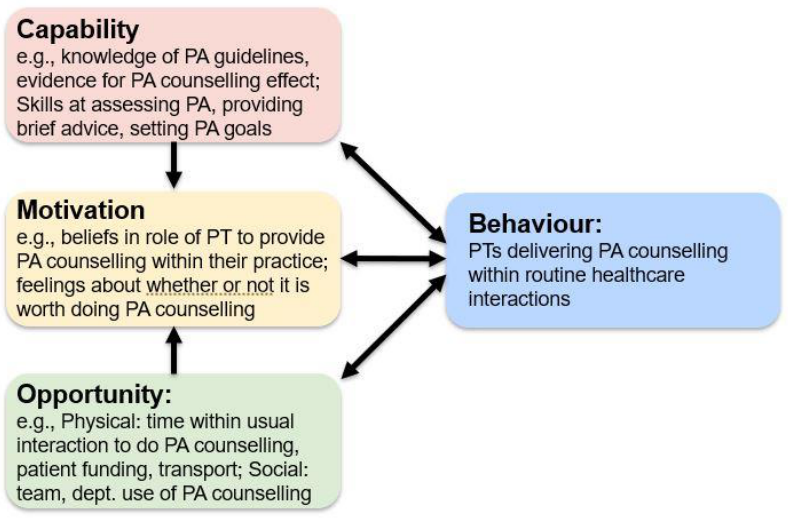
Figure 1. Examples of potential influences on physiotherapists behaviour of providing physical activity counselling framed within the COM-B theoretical model of behaviour change. Key: PA: physical activity; PT: physiotherapist; dept.: department.